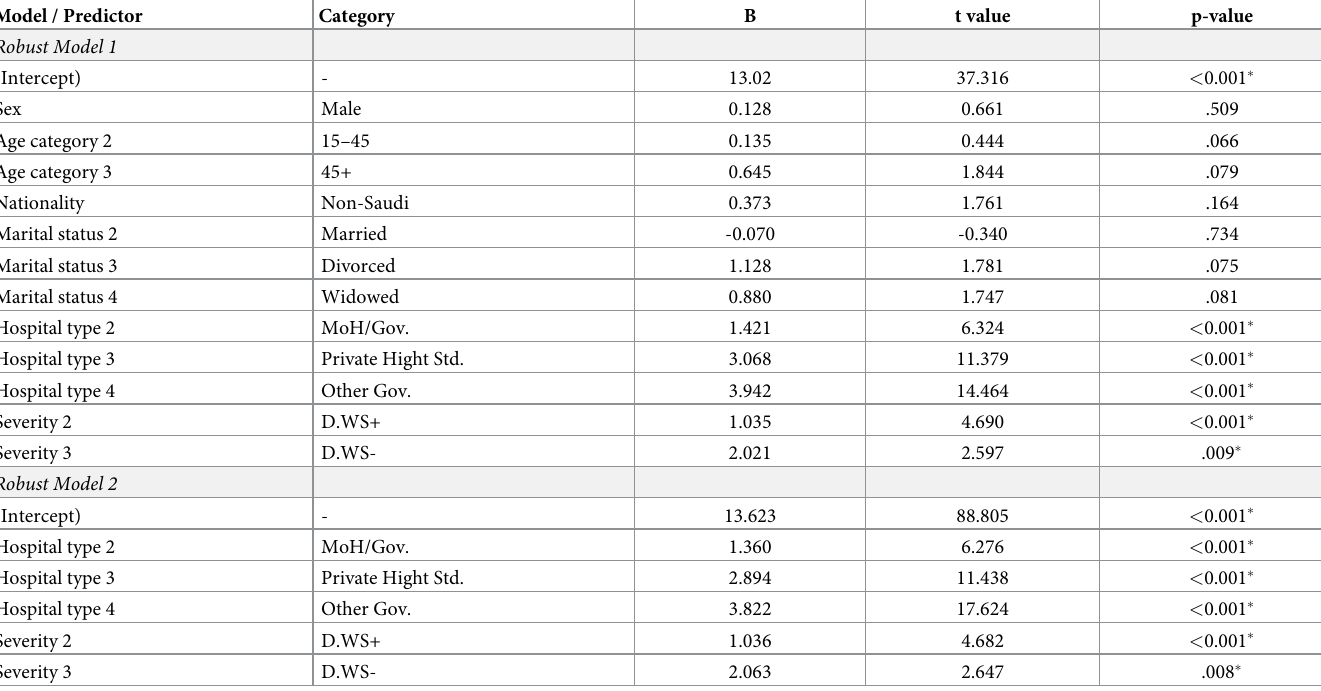
Table 4. Robust multivariate regression model to predict Box-Cox transformed direct